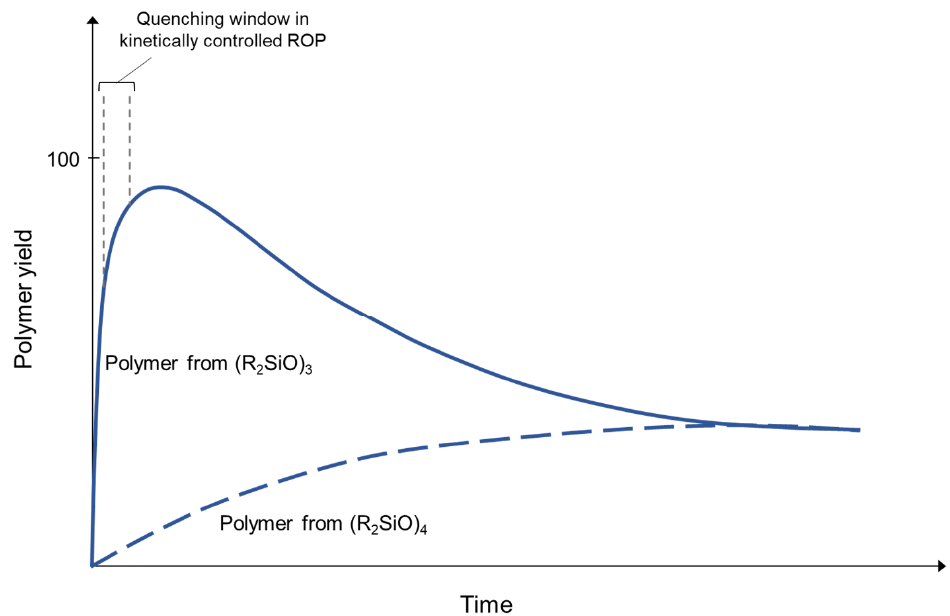
Figure 3. Time-dependent ROP polymer growth of strained versus unstrained cyclosiloxanes.